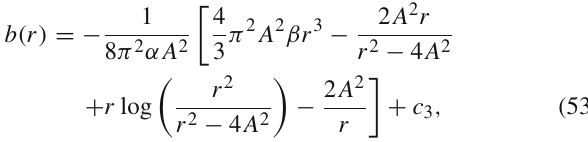
Also, we observed that for any positive α , the flaring out con- (cid:4) ( r 0 ) < 1, would satisfy at the throat of the worm- dition, b hole. In Fig. 9, we have depicted the behavior of the flare-out condition. As already defined in the previous sections, the EoS for both pressures can be read as P r P t ( r ) = ( r ) = , ω ω r t ρ ρ